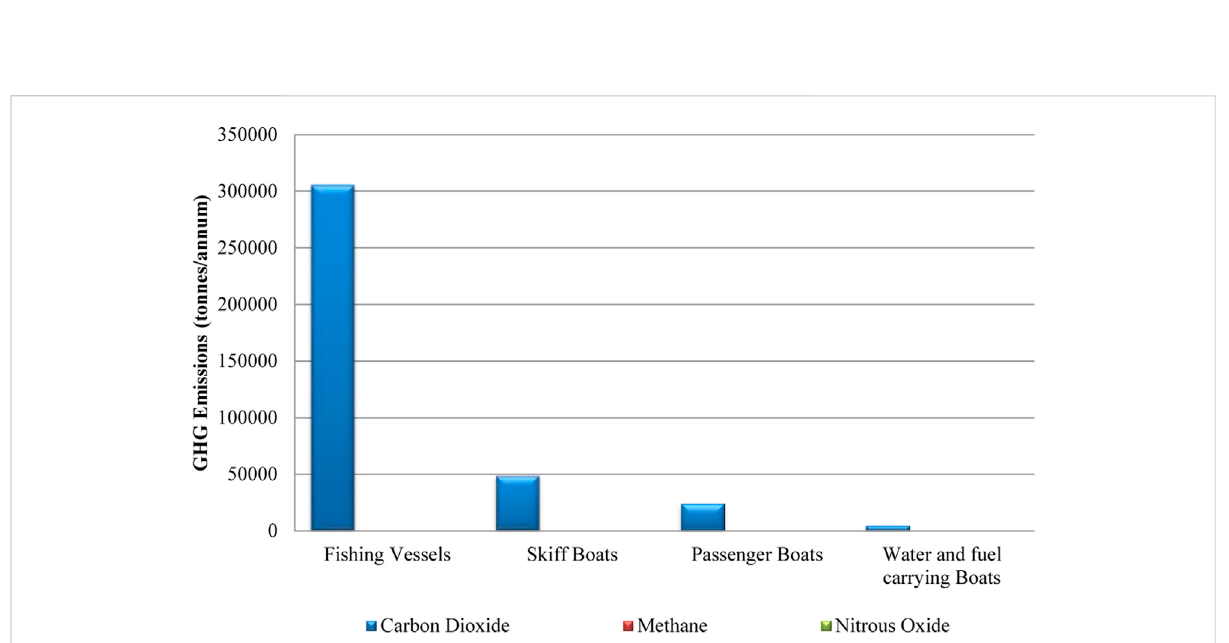
FIGURE 14 Breakdown of GHG emissions from fi shing vessels and other crafts in Balochistan,